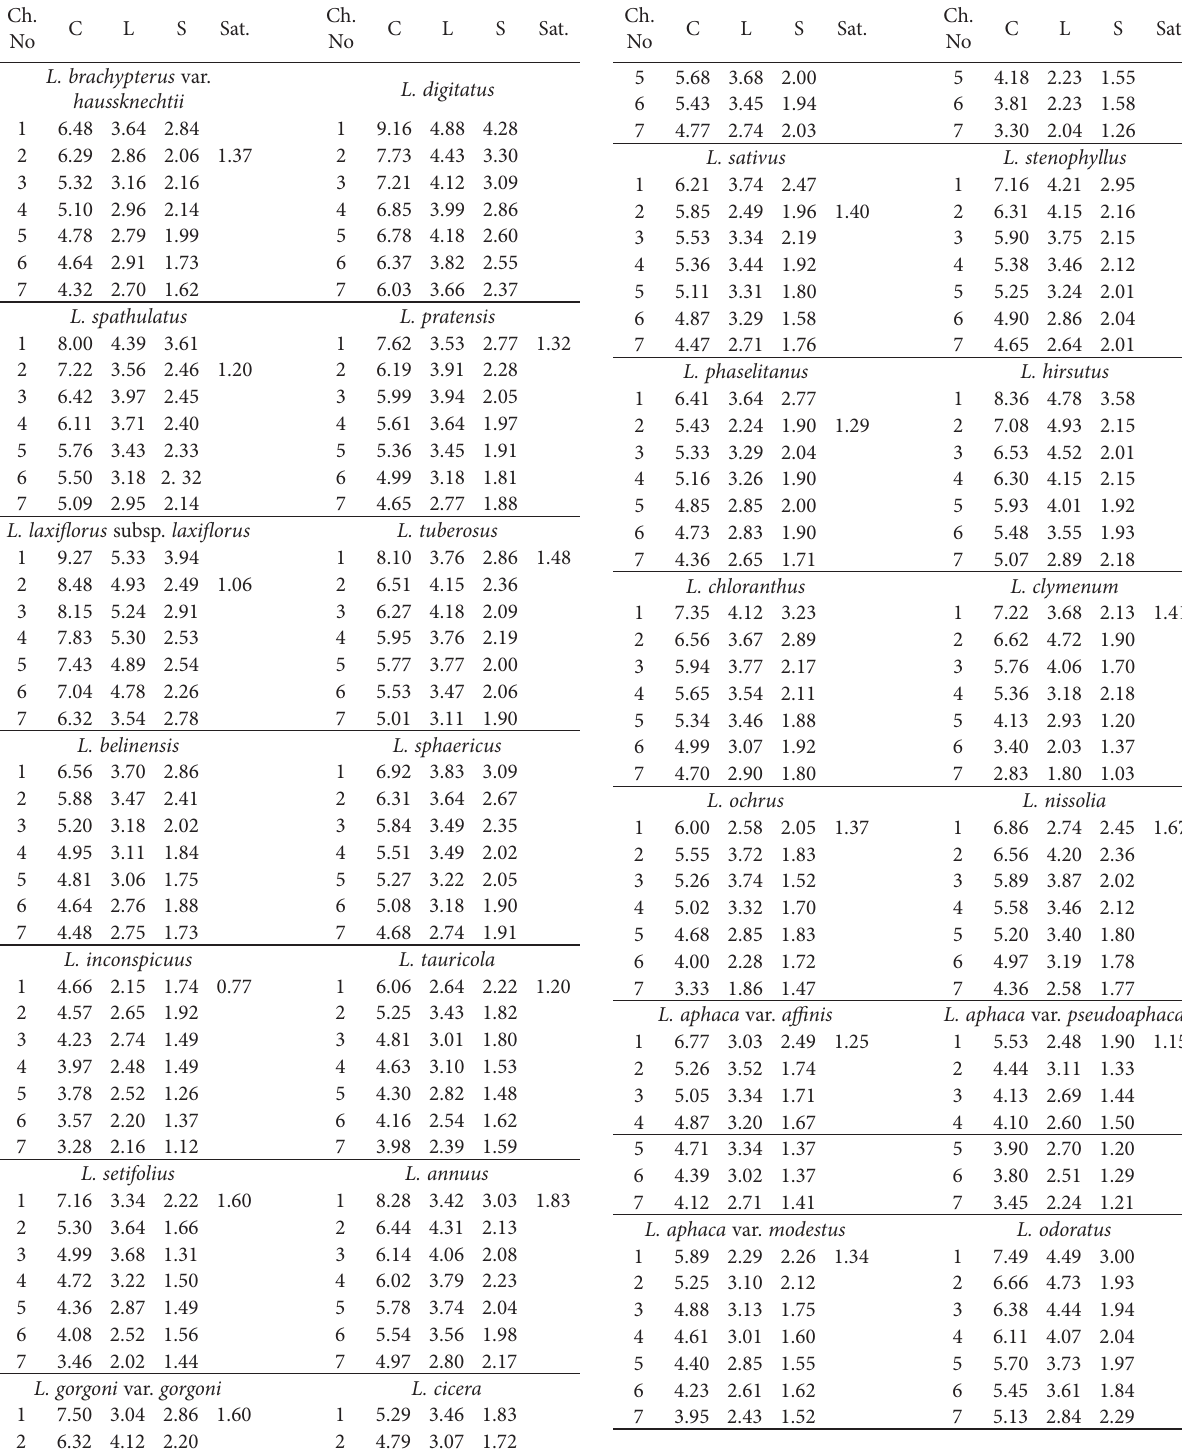
Table 2. Chromosomes measurements of Lathyrus taxa (Ch. No: Chromosome No, C: Total length of the chromosome, L: Length of the long arm, S: Length of the short arm, Sat.: